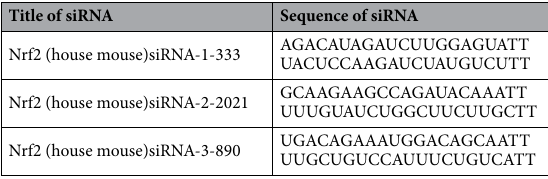
Table 1. Three gene sequences of Nrf2.